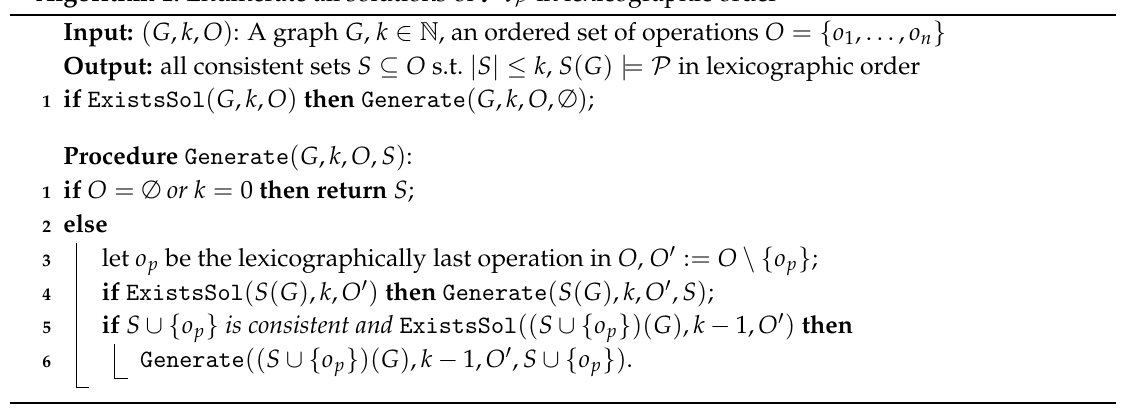
Algorithm 1: Enumerate all solutions of M P in lexicographic